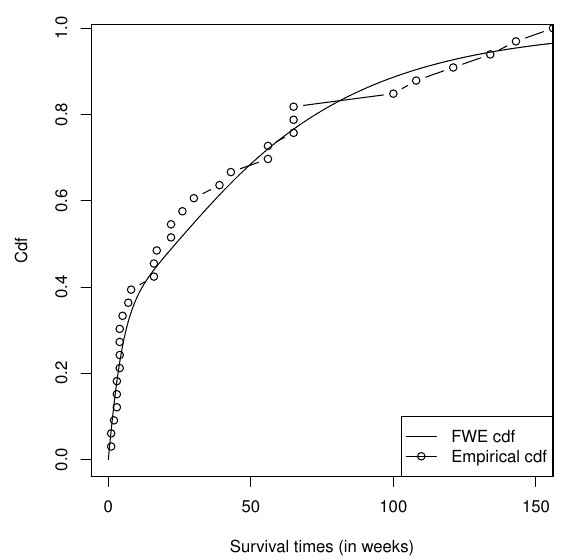
Figure 8. Fitted cdf plot of the FWE distribution for survival times